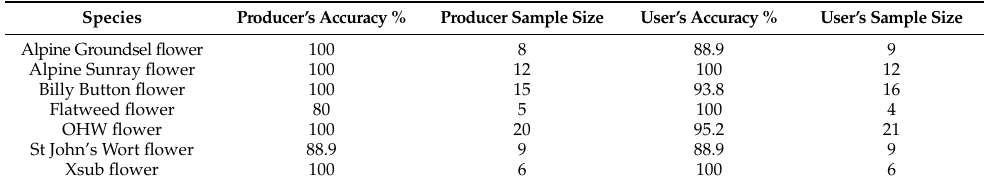
Table 5. Summary of the confusion matrix of the Random Forest classification for identifying species based on their flowers.